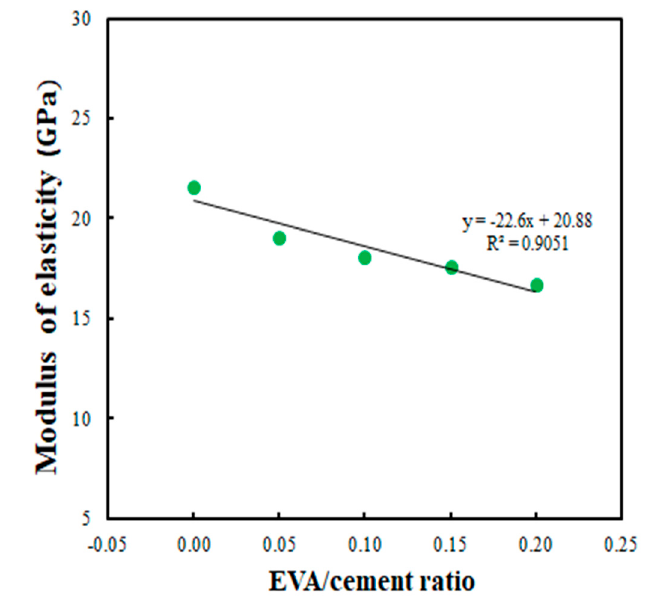
Figure 9. Relationship between the EVA/cement ratio and modulus of elasticity.